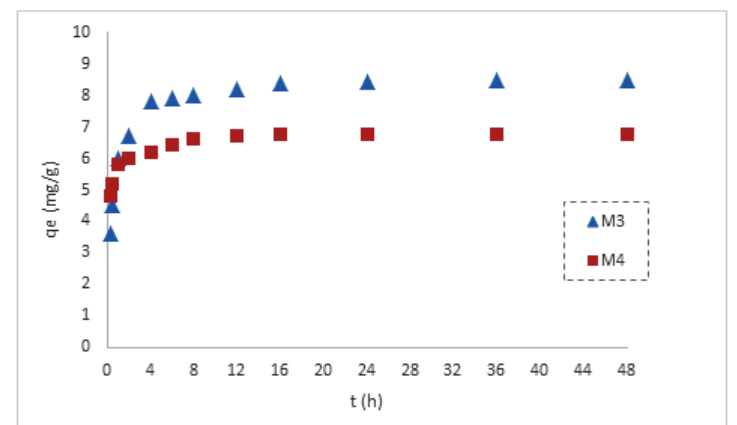
Fig. 5. The HA adsorption capacity for M3 and M4 membranes with different time intervals at pH = 7.0, m = 1 g/L, C